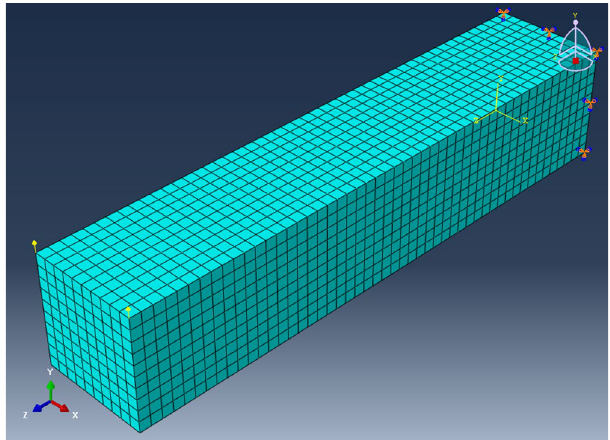
Figure 12. Hexahedron mesh of the cantilever (taken model H6 as an example).